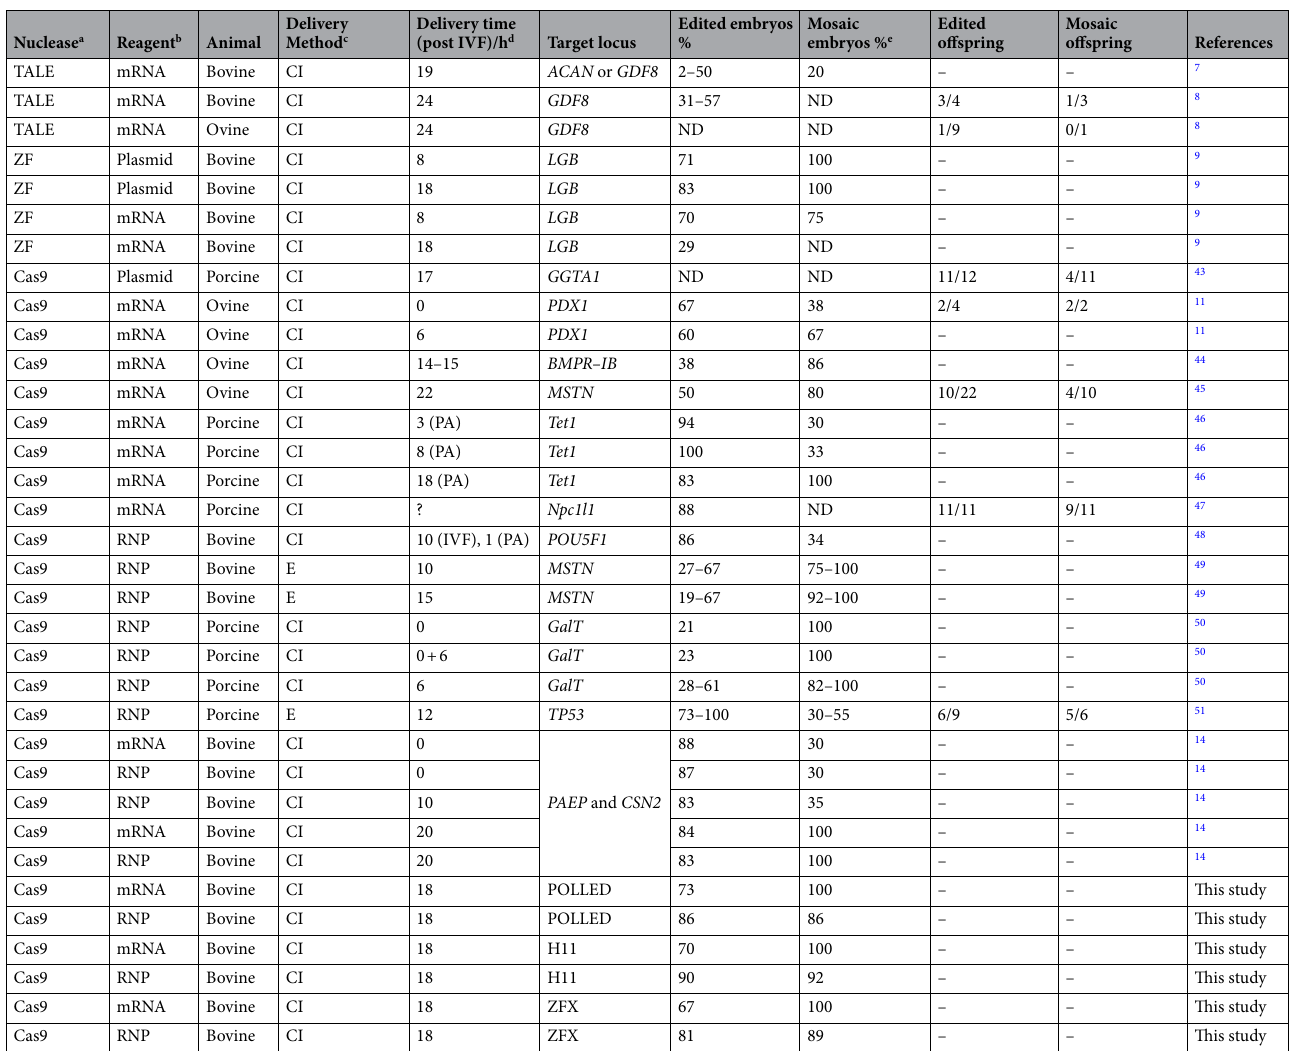
Table 3. Published results of genome editing targeting the NHEJ pathway in livestock zygotes, and rates of mosaicism (where available). Modified from Mclean et al 3 . a Transcription activator-like effector